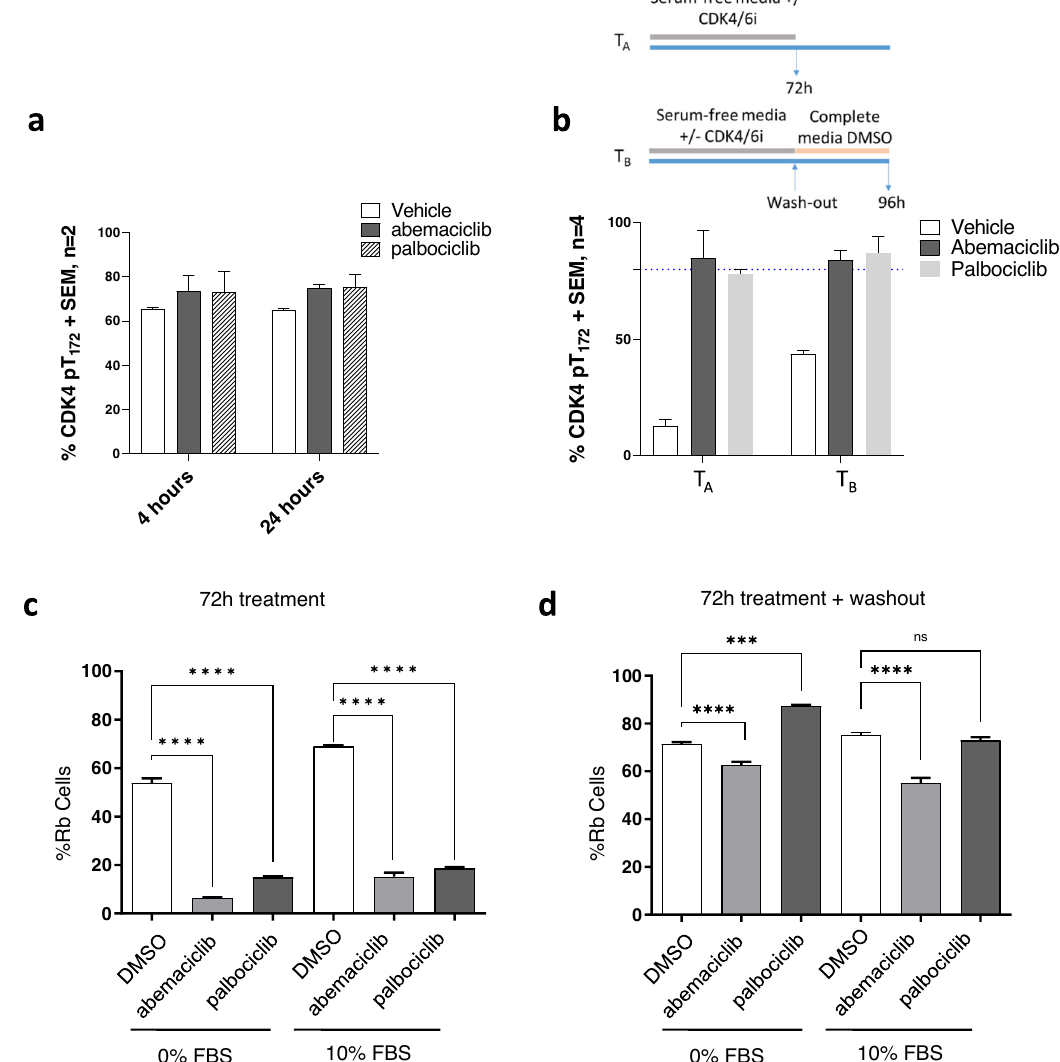
Fig. 3 CDK4-T172 phosphorylation and CDK4/6 signaling in response to CDK4/6 inhibition. T47D cells were treated with vehicle or 1 μ M CDK4/6 inhibitor for a 4 and 24 h in complete media ( n = 2) or b following mitogen deprivation and wash out ( n = 4). Cyclin D1 complexes were enriched and analyzed by LC-MS/MS. Quanti fi cation of CDK4-T172 phosphorylation is shown. Dashed blue line is baseline relative to ( a ). In ( b ) cell treatment is as described in the schematic. c Cells were treated in complete or serum-free media for 72 h with the indicated CDK4/6i (1 μ M) and imaged for pRb (S780) content. d Cells were treated as in c followed by a 24 hour washout in complete media lacking inhibitors prior to pRb imaging. Rb protein phosphorylation was measured by high content imaging. ** p < 0.01, **** p < 0.0001, ns – not signi fi cant. P-values determined by pairwise t-test. Error bars represent ± standard